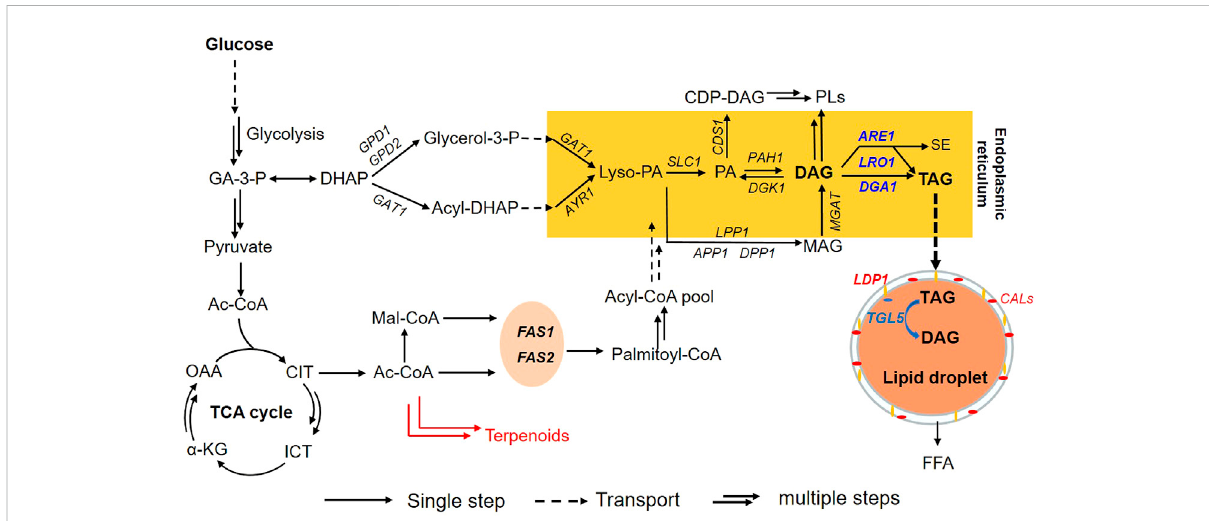
FIGURE 2 TAG related metabolism of R. toruloides . Metabolites (joined byarrows; a single arrow meansone step, and double arrowsmean multiple steps whileabrokenarrowmeanstransport)andenzymes(namedinthemiddleofthearrow)involvedinTAGmetabolismareshown.Thecommonlyused names for metabolites and enzymes are used as abbreviations. Two cellular compartments for lipid synthesis and storage are also indicated: endoplasmic reticulum and lipid droplet, two important structural genes of lipid droplet were noted as yellow ( LDP1 ) and red ( CALs ). Enzymes named in blue correspond to genes that have been already engineered in this study. DGA1, LRO1, and ARE1 are three genes of the fi nal step of TAG synthesis from DAG in R. toruloides, and TGL5 is a TAG hydrolysis gene. Abbreviations: FAS1 and FAS2 are fatty acid synthetase; TAG,